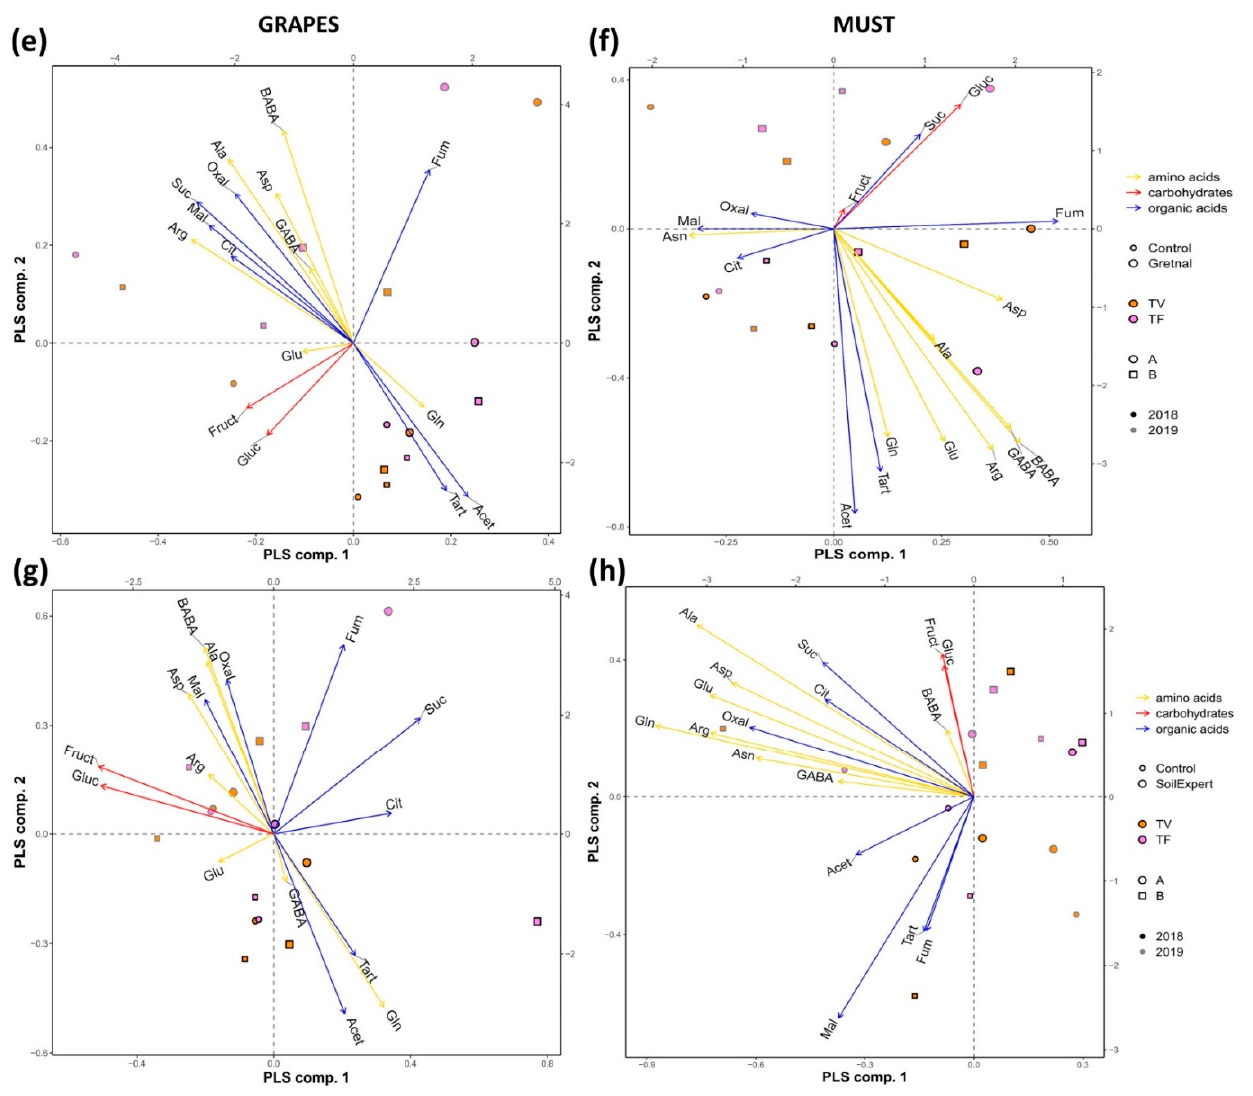
Figure 7. Partial least squares discrimination analysis (PLS-DA) in grapes ( a ) and must ( b ) of Vitis vinifera var. Tempranillo sprayed with distilled water (control) vs. BABA; grapes ( c ) and must ( d ) of Vitis vinifera var. Tempranillo sprayed with distilled water (control) vs. Basofoliar (BF); grapes ( e ) and must ( f ) of Vitis vinifera var. Tempranillo sprayed with distilled water (control) vs. Greetnal (GT); grapes ( g ) and must ( h ) of Vitis vinifera var. Tempranillo sprayed with distilled water (control) vs. SoilExpert (ST); from two subplots (A and B) collected before and after harvest (TV and TF).